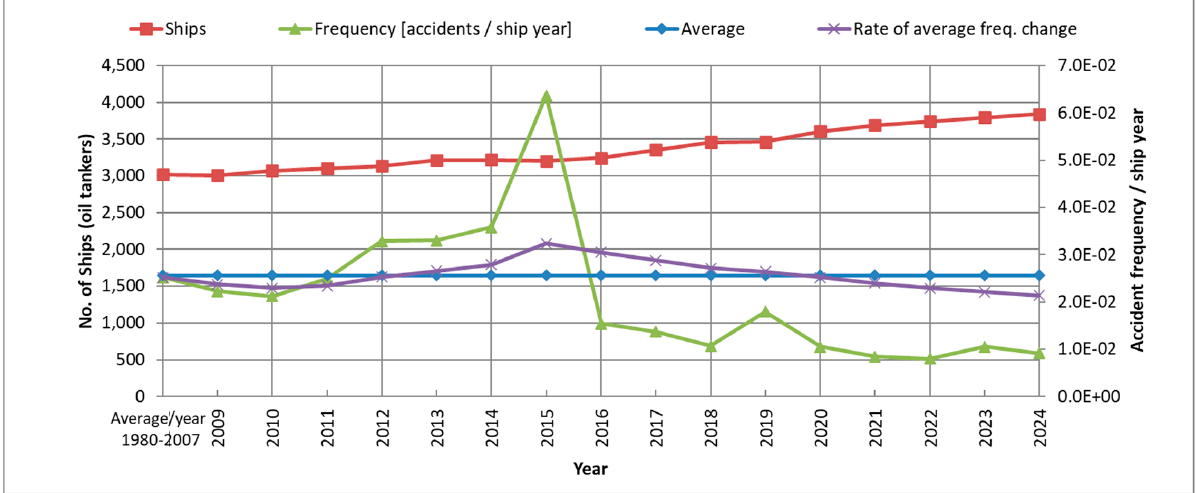
Figure 2. Accident frequency, year-by-year (per ship).